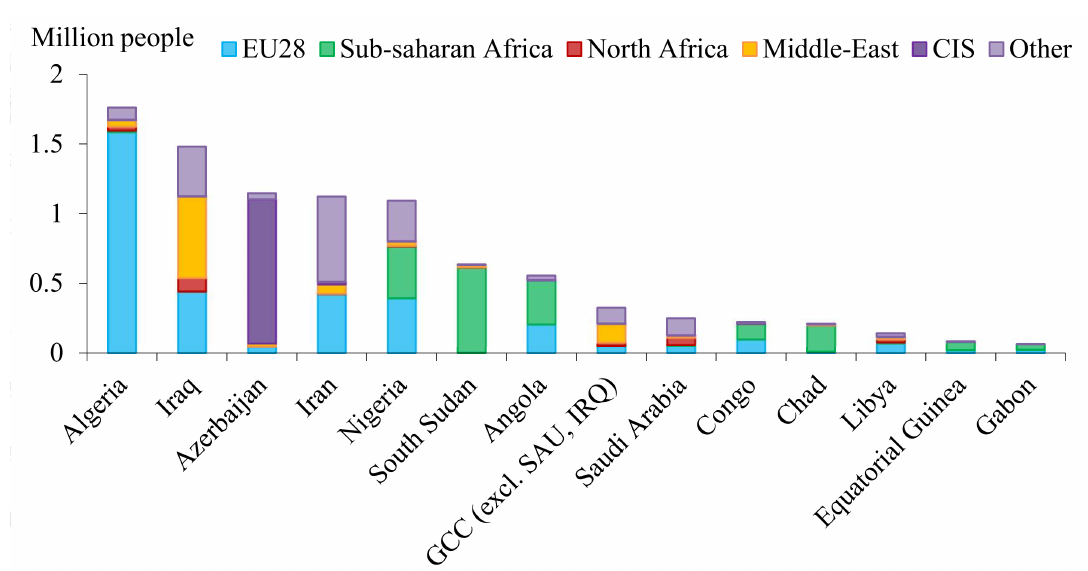
Figure A1. Foreign residents (in millions) originating from oil-exporting countries